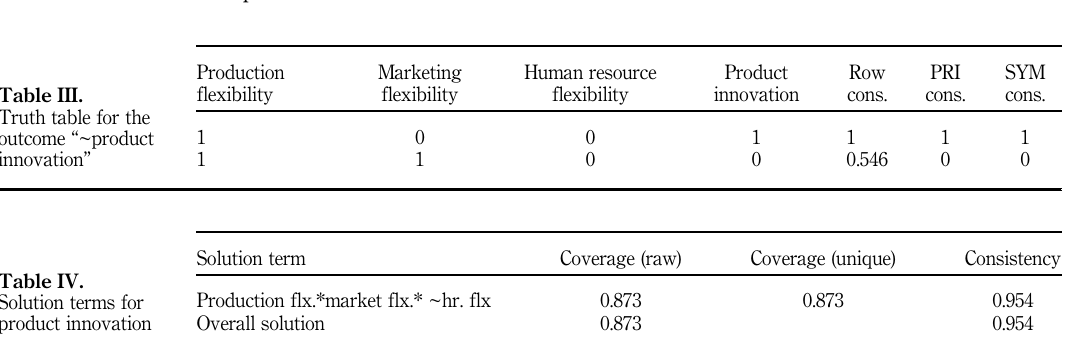
Table IV. Solution terms for product